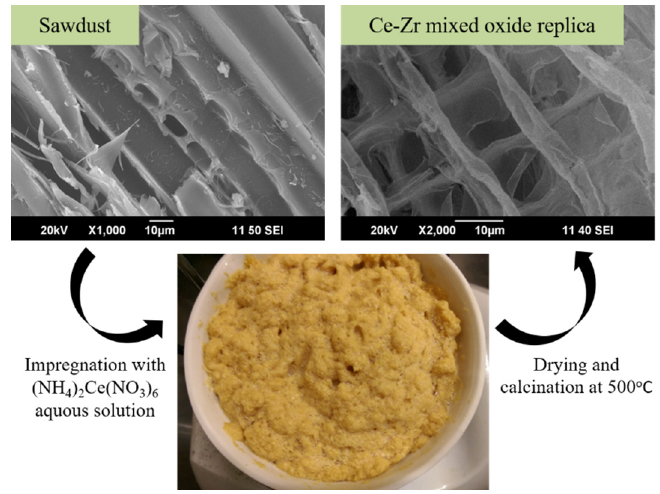
Figure 7. Biomorphic CeZrO x reproduces well the morphology of biotemplate: SEM images of pine sawdust and CeZrO x produced using this sawdust as biotemplate.